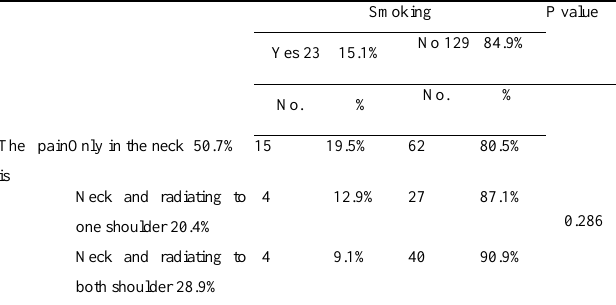
Table (6): Show the correlation between neck pain and smoking